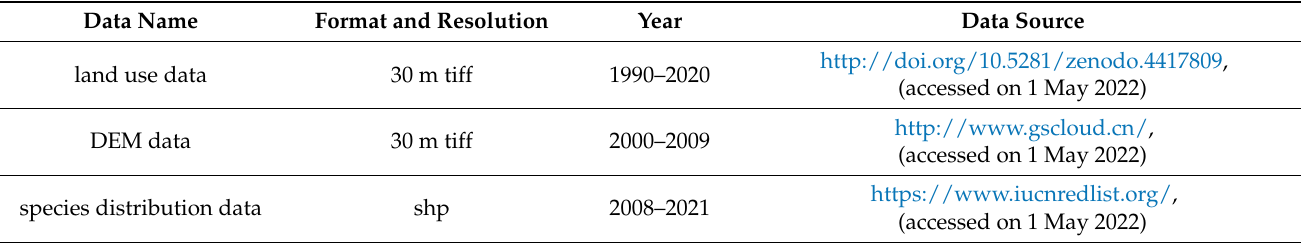
Table 1. Basic data list.